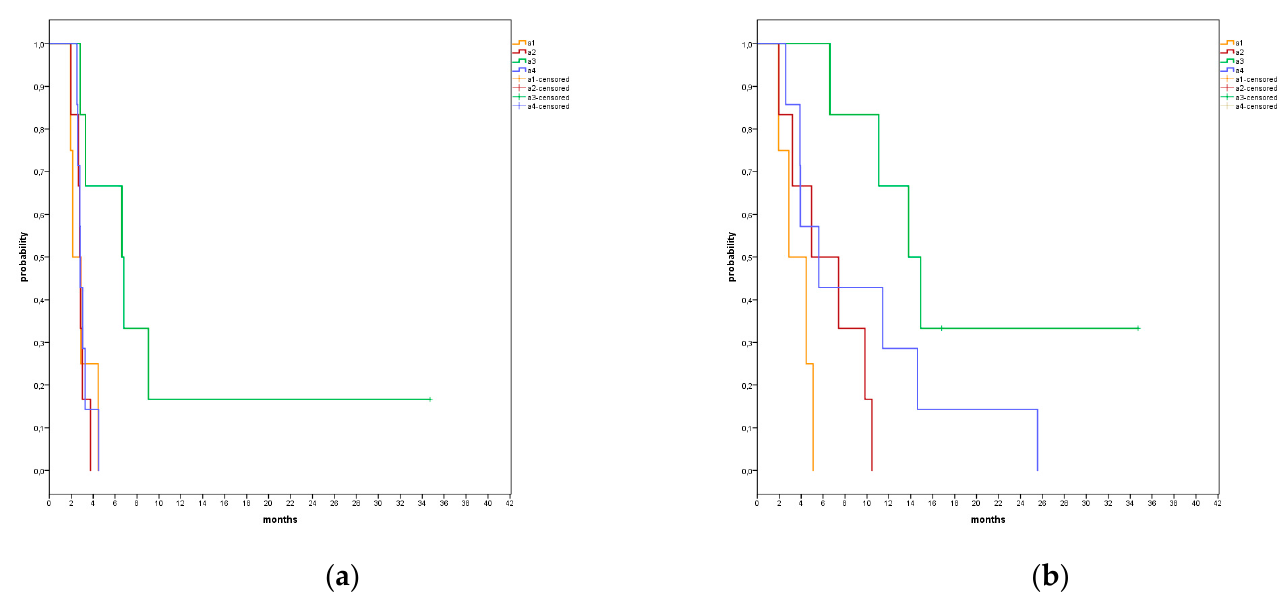
Figure 4. Kaplan–Meier test results for PFS ( a ) and for OS ( b ) divided in four areas (A1 (4 pts) = orange, A2 (5 pts) = red, A3 (7 pts) = green, A4 (7 pts) = blue).